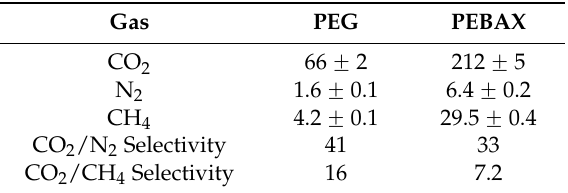
Table 2. Single gas permeability (Barrer) and ideal selectivity through PEG and PEBAX membranes at 35 °C and 600 kPa.